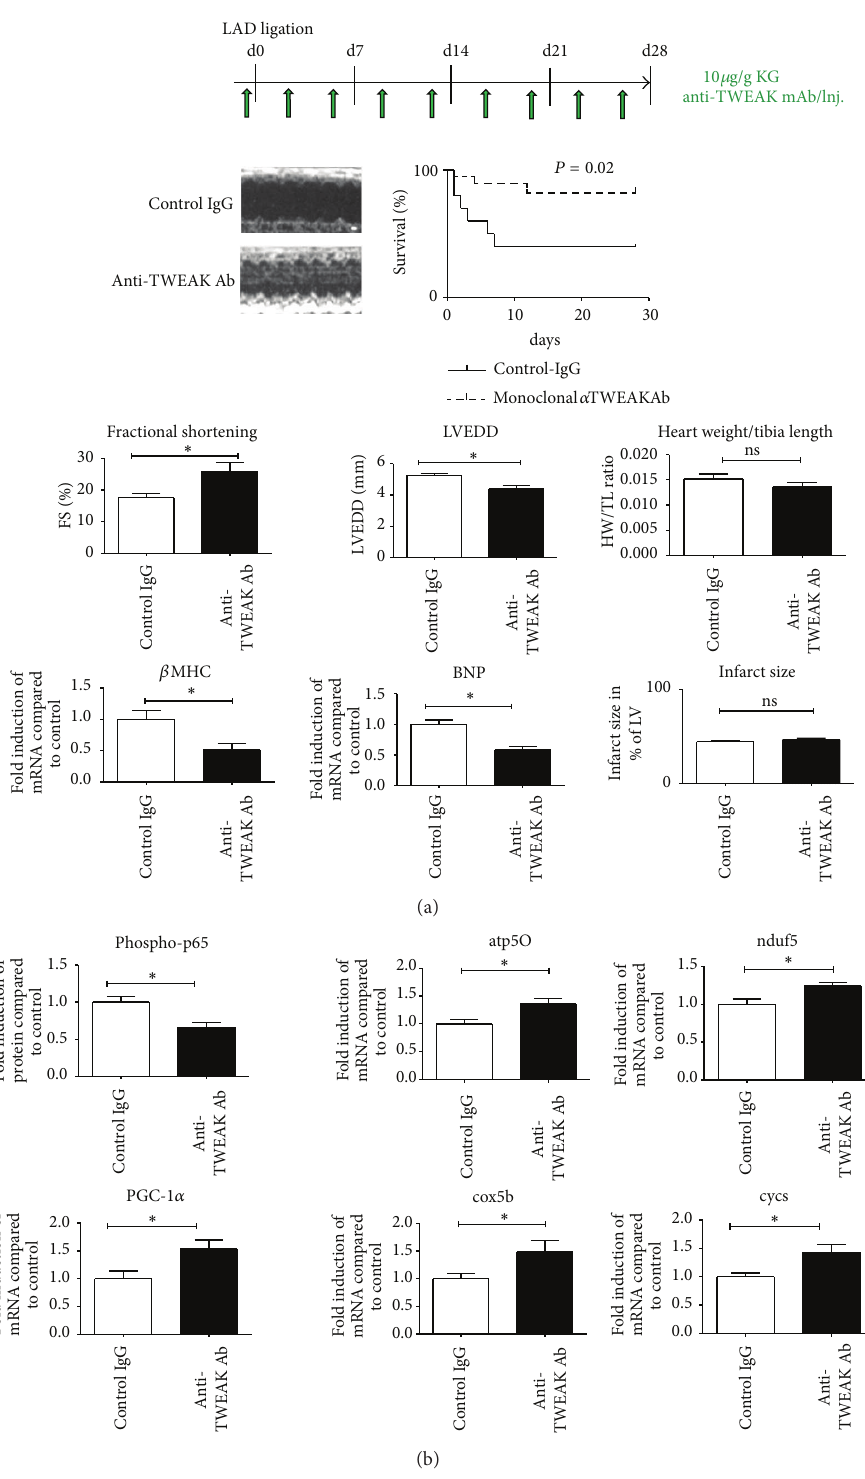
Figure 6: Inhibition of intrinsic TWEAK activity improves survival after myocardial infarction in mice. (a) CD-1 mice were treated with neutralizing monoclonal antibodies against TWEAK or control IgG for 4 weeks after myocardial infarction. Anti-TWEAK treatment resulted in improved survival, preserved left ventricular function, and reduced expression of 𝛽 -MHC and BNP. These effects were independent of infarct size and the degree of left ventricular hypertrophy. (b) Anti-TWEAK treatment reduced the phosphorylation of p65 in the remote myocardium and preserved the expression of PGC-1 𝛼 and OXPHOS genes like atp5O, ndufb5, cycs, and cox5b (molecular analysis 𝑛 = 6 for each group; functional analysis 𝑛 = 12 for each